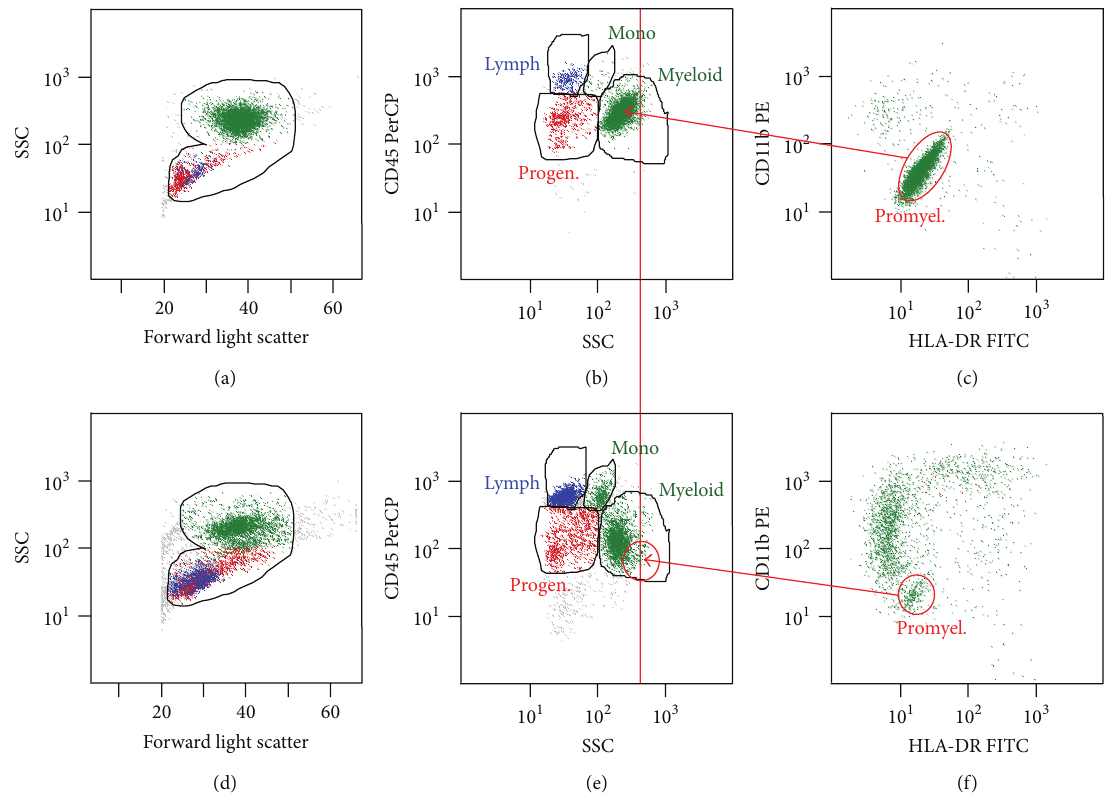
Figure 3: (a, b, c) Flow cytometric analysis of the bone marrow, following induction I chemotherapy. The dominant cell population, 56% of nonerythroid cells (green), was consistent with abnormal hypogranular promyelocytes that expressed neither CD11b nor HLA-DR but were highly autofluorescent. (d, e, f) Similar analysis of bone marrow, following induction II, demonstrated the appropriate right angle light scatter for promyelocytes (vertical red line) with the majority of maturing myeloid cells now expressing CD11b, that is, myelocytes-segmented